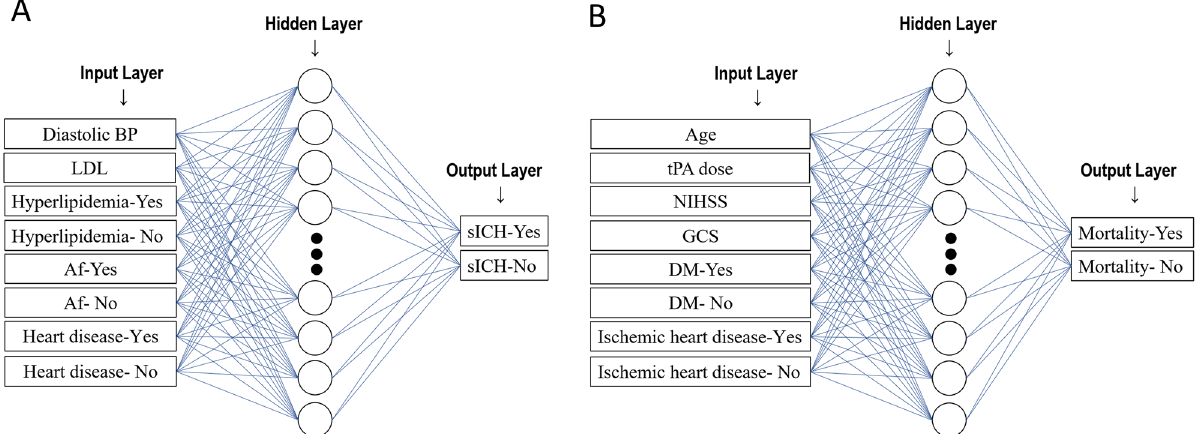
Figure 1. Artificial neural network (ANN) models in the present study. Schema showing the input, hidden, and output layers of ( A ) ANN model 1 to predict sICH, and ( B ) ANN model 2 to predict the 3-month mortality. Af, atrial fibrillation; ANN, artificial neural network; BP, blood pressure; DM, diabetes mellitus; GCS, Glasgow Coma Scale; sICH, symptomatic intracranial hemorrhage; LDL, low-density lipoprotein; NIHSS, National Institutes of Health Stroke